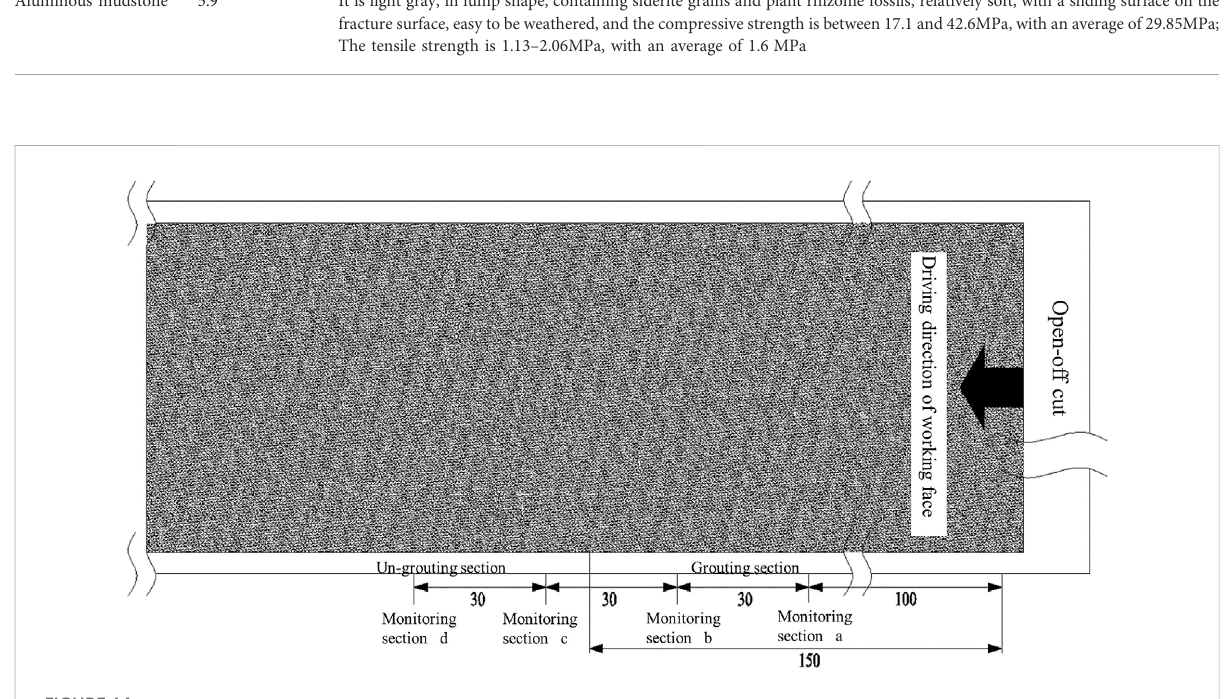
FIGURE 14 Roadway monitoring cross-section